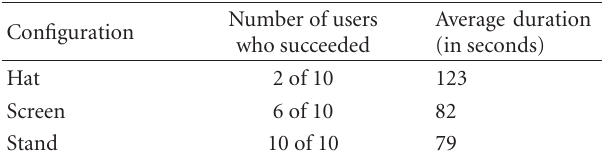
Table 1: Camera position.